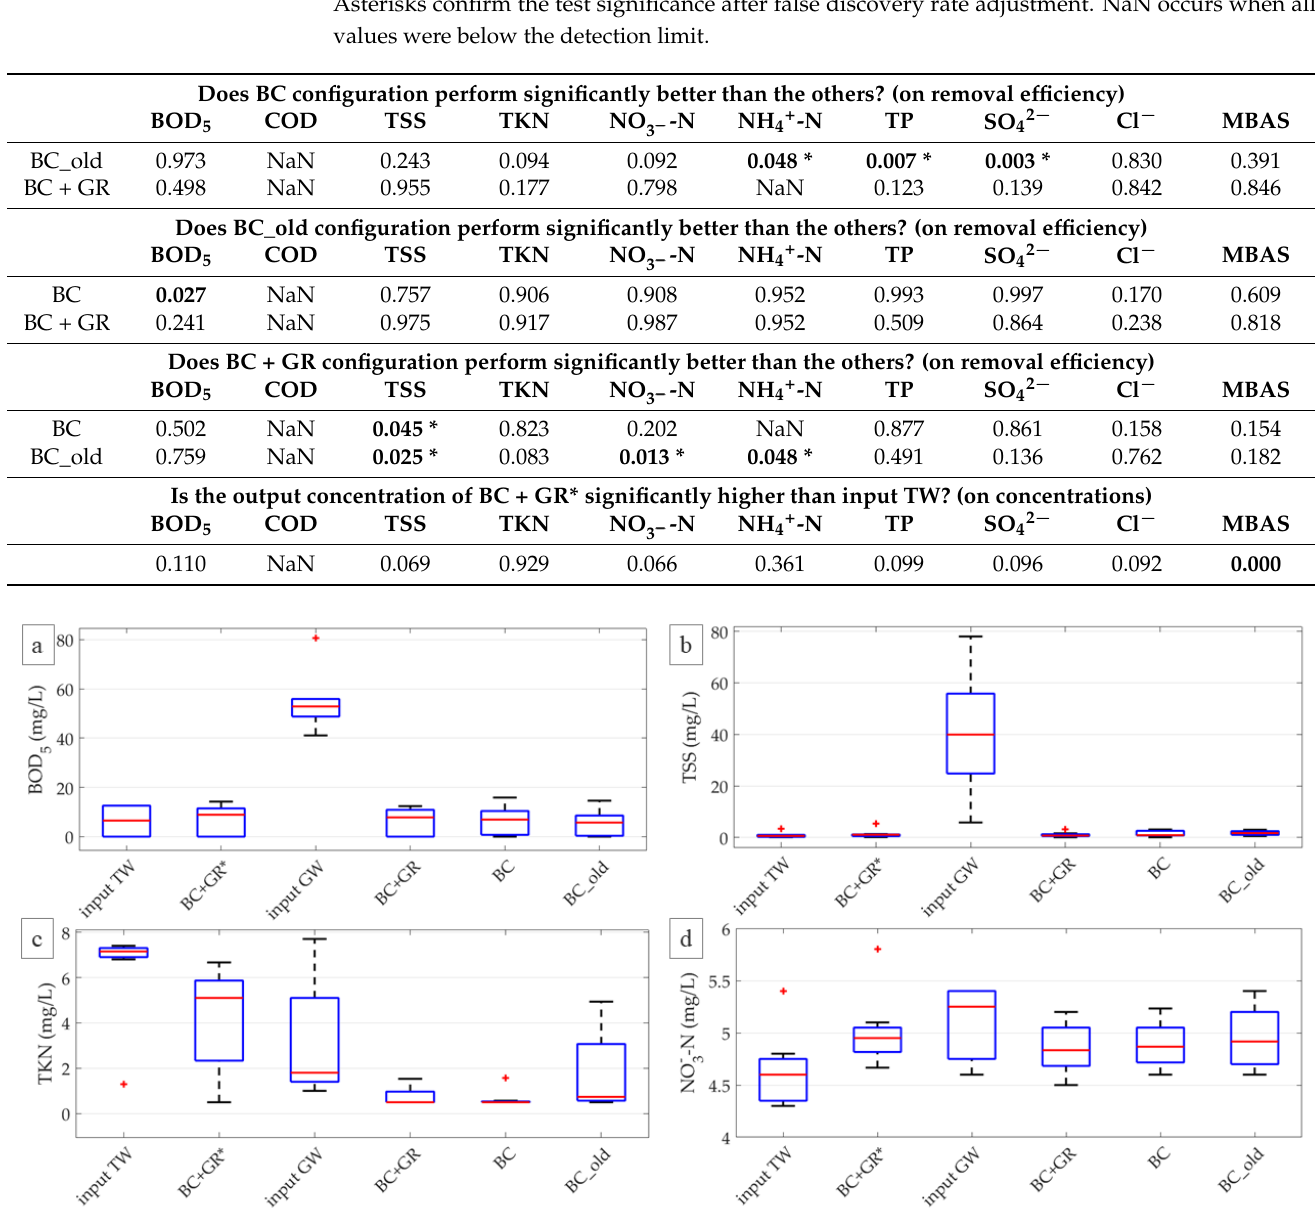
Figure 3. Values of the parameters measured off-site on input (TW and GW) and output samples from all configurations (( a ): BOD 5 , ( b ): TSS, ( c ): TKN, ( d ): NO 3 − -N). Median value (red line), 25th and 75th percentiles (blue box), range (black whiskers) and outliers (red cross) are